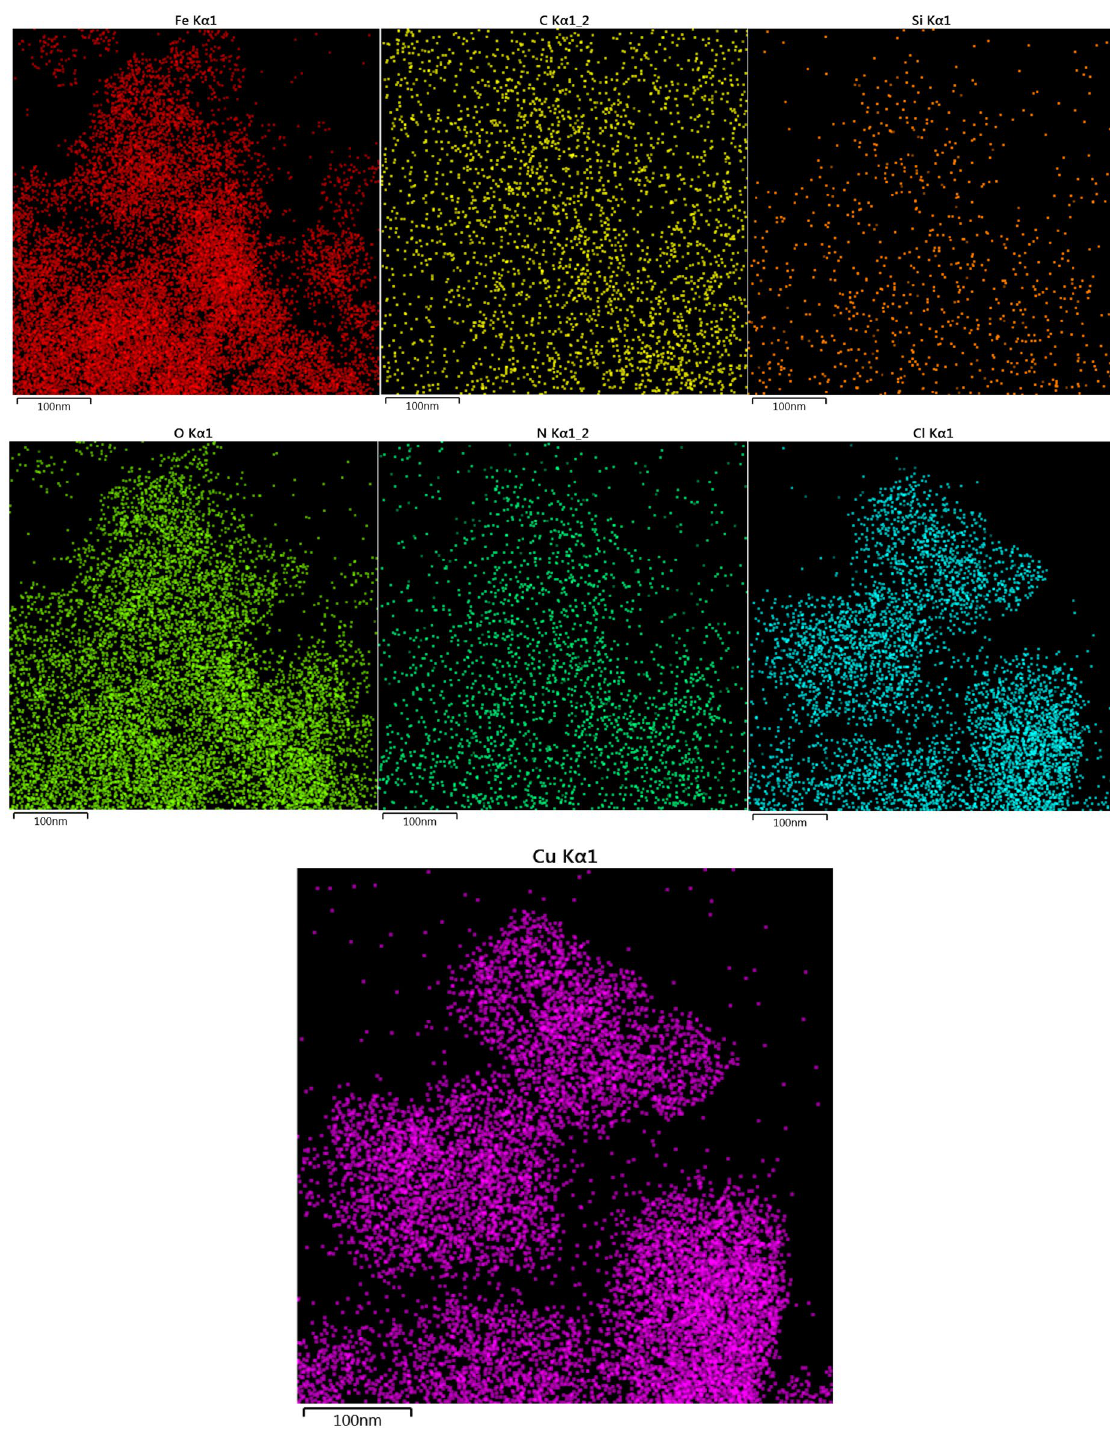
Figure 9. Elemental mapping of Ps@Tet-Cu(II)@Fe 3 O 4